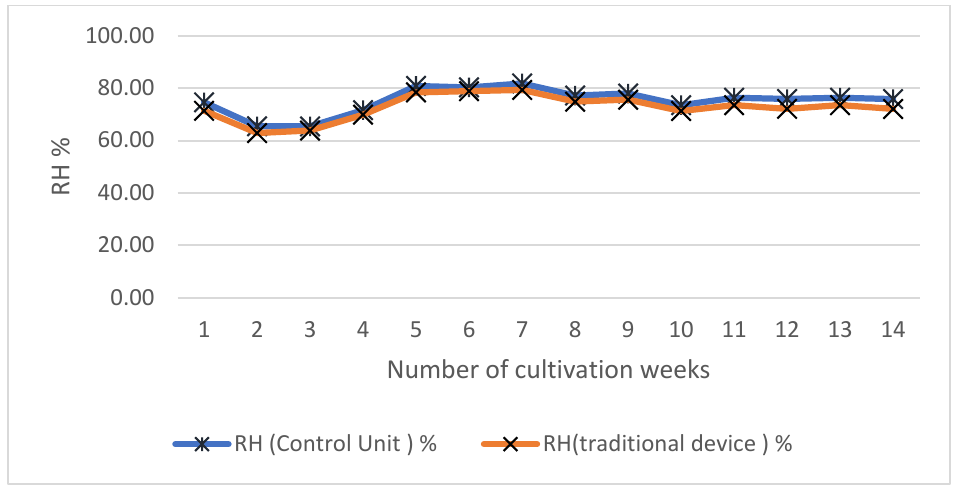
Figure 7. Results of RH from an Arduino microcontroller system and traditional devices by week.